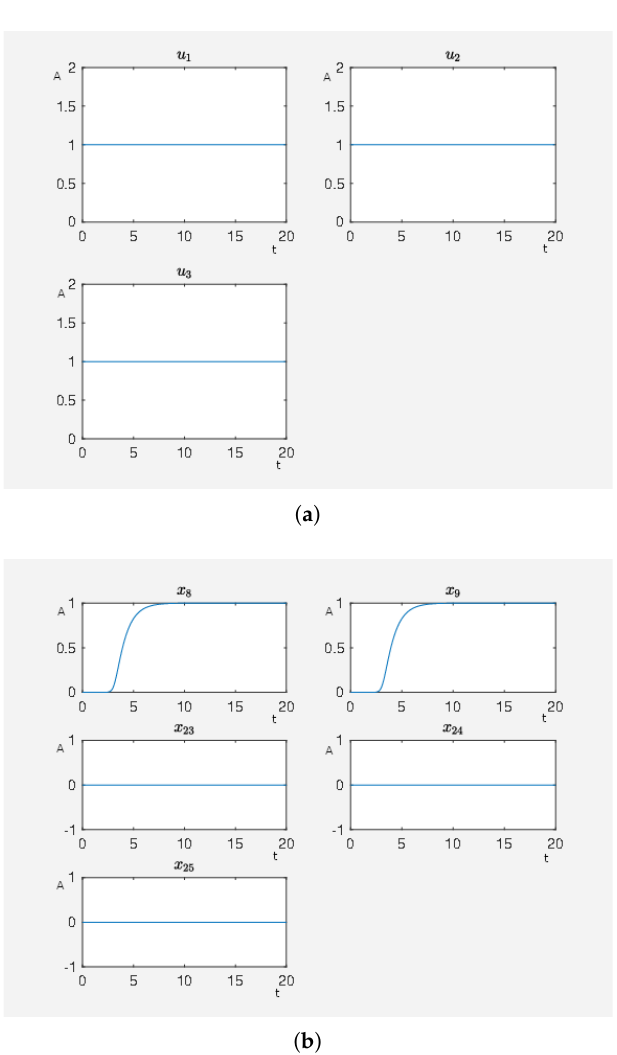
Figure 6. A non-hypertrophic stimulus by angiotensin II and isoproterenol with the inhibition of the third ERK1/2 ERK Thr188 phosphorylation. ( a ) Time curve of the external stimuli where u 1 activates angiotensin II, u 2 on isoproterenol and u 3 inhibits ERK1/2 dim 3P. On the abscissa, we have the time (t) and on the ordinate the activity level (A). ( b ) Time curve of the nodes of interests where x 8 is the activity level of p90RSK, x 9 is the activity level of p70S6K, x 23 is the activity level of Elk1, x 24 is the activity level of MSK1 and x 25 is the activity level of c-Myc. On the abscissa, we have the time (t) and on the ordinate the activity level